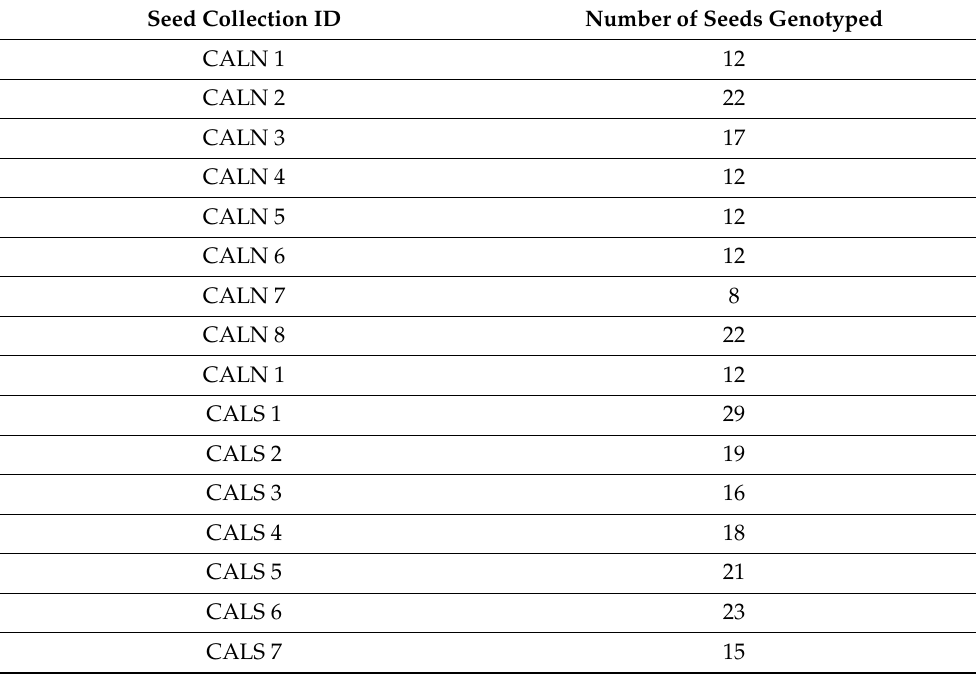
Table A1. Total number of genotyped seeds per collection location. Collection locations noted by population code and location